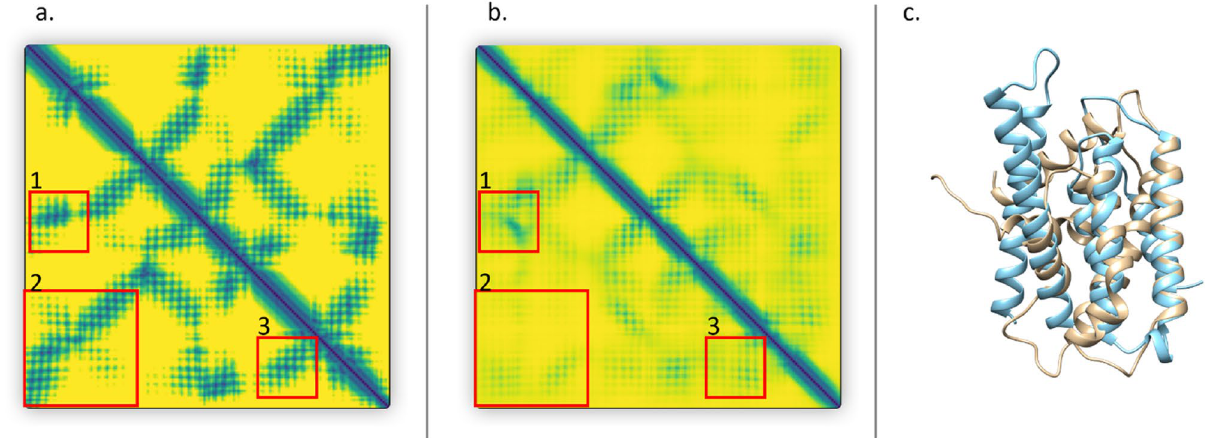
Figure 7. A failed example (T1039). ( a ) the true distance map. ( b ) the predicted distance map. ( c ) top model selected by MULTICOM-AI (light blue) versus true structure (light yellow), both protein structures were visualized by Chimera 50 (version 1.15, URL: https:// www. cgl. ucsf. edu/ chime ra/). Red boxes highlight